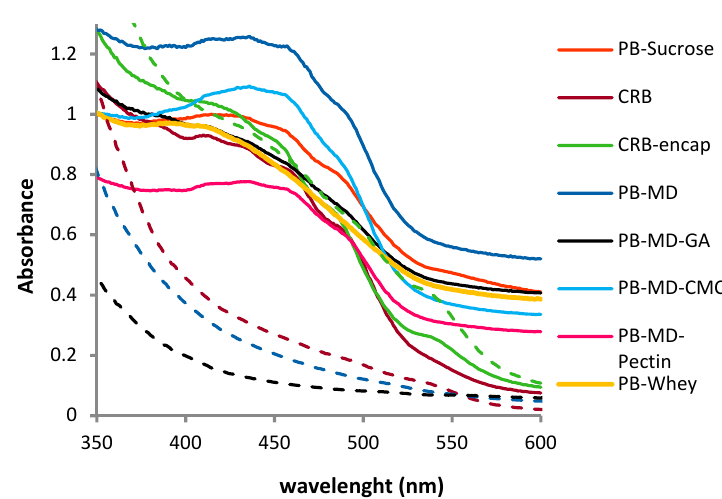
Figure 7. Visible spectra of pure bixin microcapsules aqueous solution/dispersions before and after physical stability tests. At 0 h, concentrations of CRB and CRB-encap were 0.1 mg/mL and 0.048 mg/mL respectively. Visible spectra after physical stability tests were taken of the supernatant of samples prepared at 0.3 mg/mL for CRB and CRB-encap. For all other systems, 1.5 mg/mL was employed. The solid lines show the visible spectra at time 0 h, whereas the dashed line shows the lack of absorbance (characteristic bands) after the colorant particles have settled.